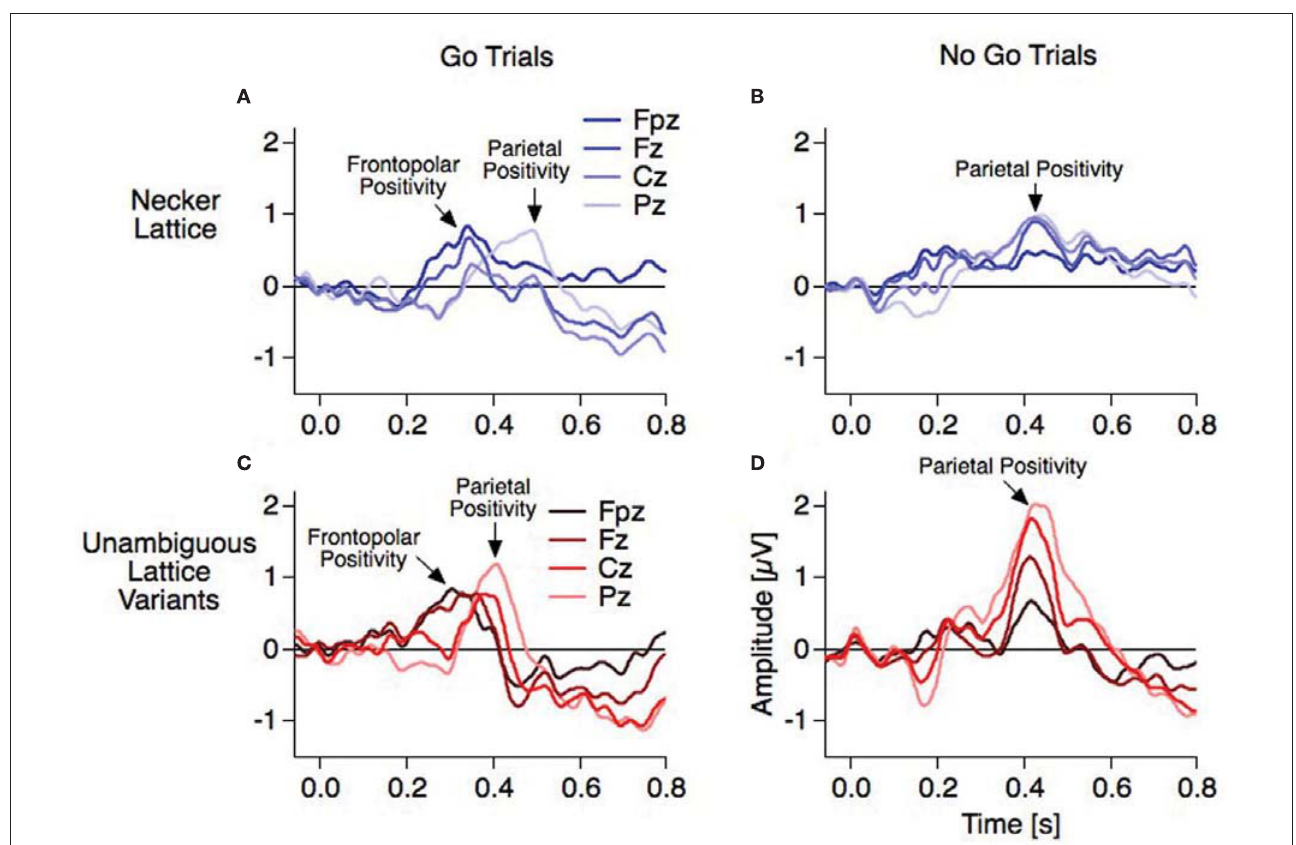
FIGURE 11 | Parietal and frontopolar positivities (dERPs) along the midline electrodes. (A,C) Temporally and spatially separated Parietal and Frontopolar Positivities occur in the go trials. (B,D) The Frontopolar Positivity,